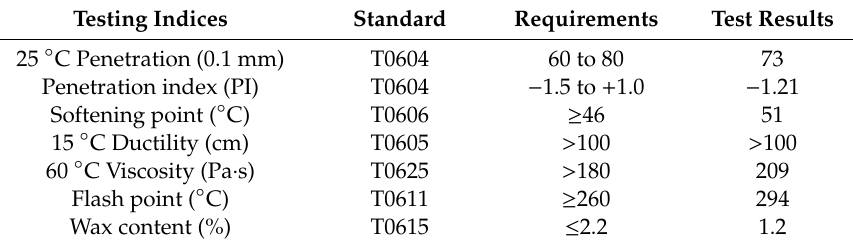
Table 2. Main physical properties of asphalt binder.